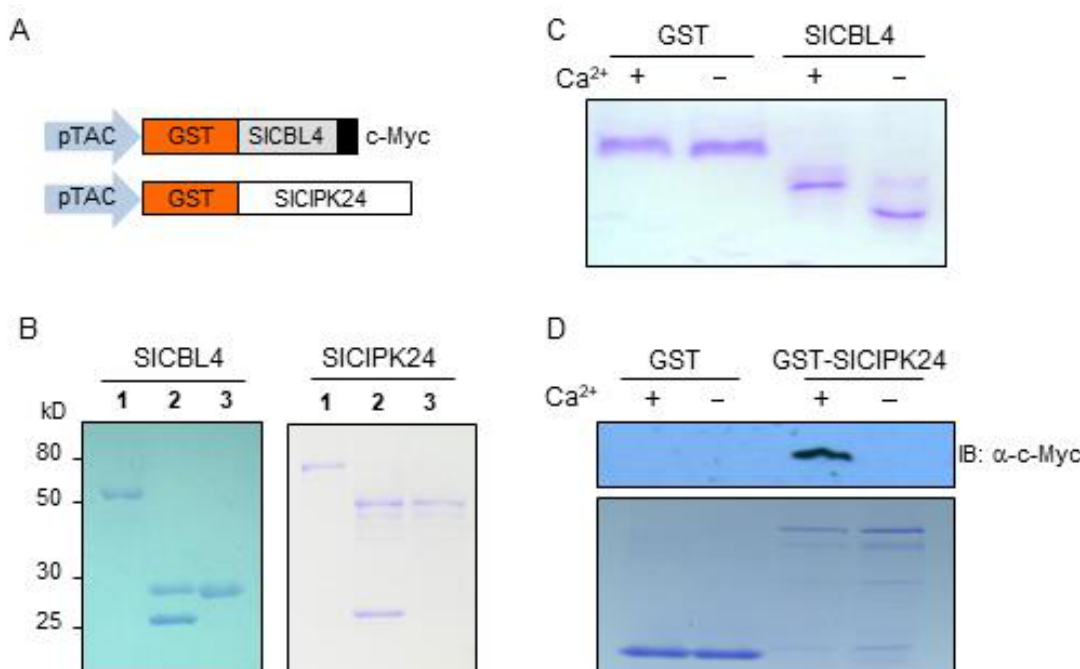
Figure 3. Recombinant SlCBL4 protein possesses Ca 2+ -binding activity and interact with SlCIPK24 in vitro. ( A ) Schematic diagrams of pGEX-SlCBL4:c-Myc and pGEX-SlCIPK24 constructs. ( B ) Expression and purification of the recombinant SlCBL4 and SlCIPK24 proteins. Lanes 1 to 3 contain the GST-fused forms, the thrombin-digested forms, and purified forms, respectively. The proteins were analyzed by SDS-PAGE and stained with Coomassie Brilliant Blue. The molecular masses of the proteins are indicated at left in kilodaltons (kD). ( C ) Gel mobility shift assay showing Ca 2+ -binding activity of the SlCBL4:c-Myc protein. The recombinant SlCBL4:c-Myc protein was incubated in EGTA-(-) or calcium-containing buffer (+) before being analyzed by 12% native PAGE. GST protein was used as a negative control. ( D ) Pull-down assay demonstrating a Ca 2+ -dependent SlCBL4-SlCIPK24 association. The GST-SlCIPK24 fusion protein was used as a bait to retrieve the prey SlCBL4:c-Myc in the presence (+) or absence (-) of calcium. For a negative control, the GST was used as bait. Top panel is an immunoblot probed with mouse anti-c-Myc antibody. Bottom panel is a Coomassie Blue-stained SDS-PAGE gel showing the amount of the bait proteins used in the assay.